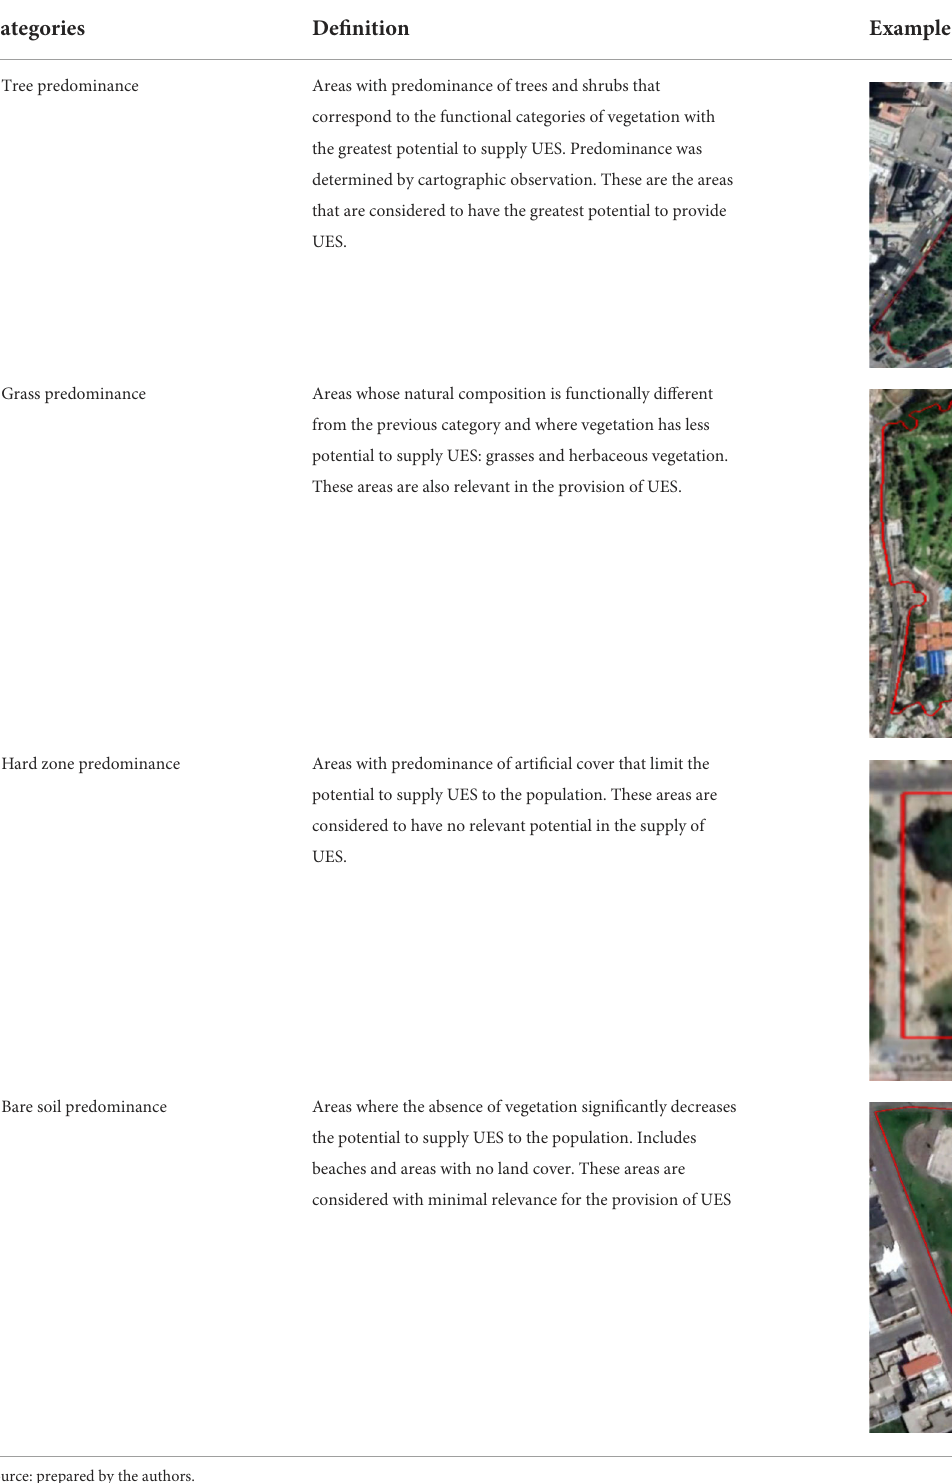
TABLE 2 Functional categories of public